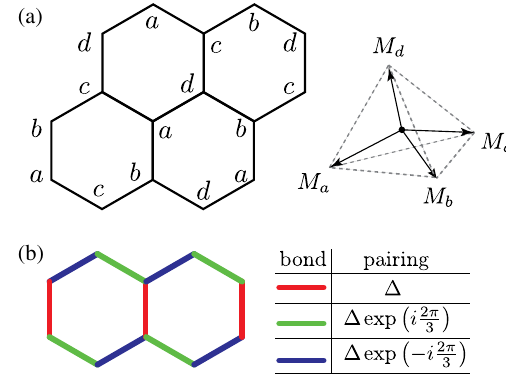
FIG. 2. (a) The chiral spin-density wave and (b) d þ id pairing order parameters in real